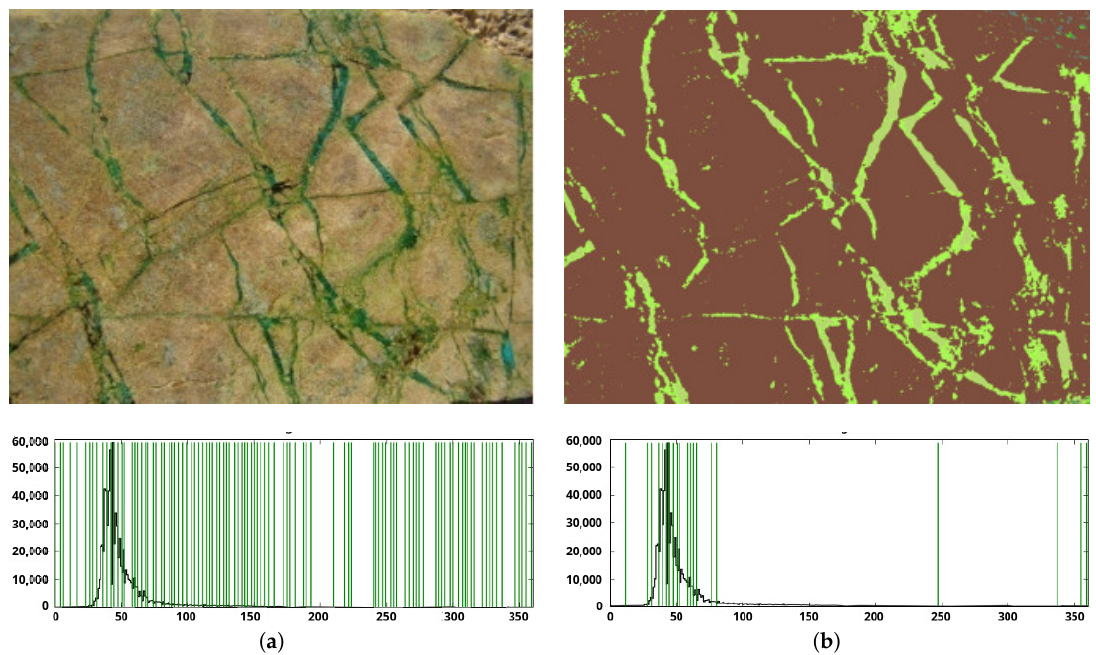
Figure 3. Segmented images in RGB space ( top ) and their corresponding histograms of hue values ( bottom ) with partitions. Column ( b ) show the results of color segmentation by searching unimodal distributions in the color histogram of the hue channel (column ( a